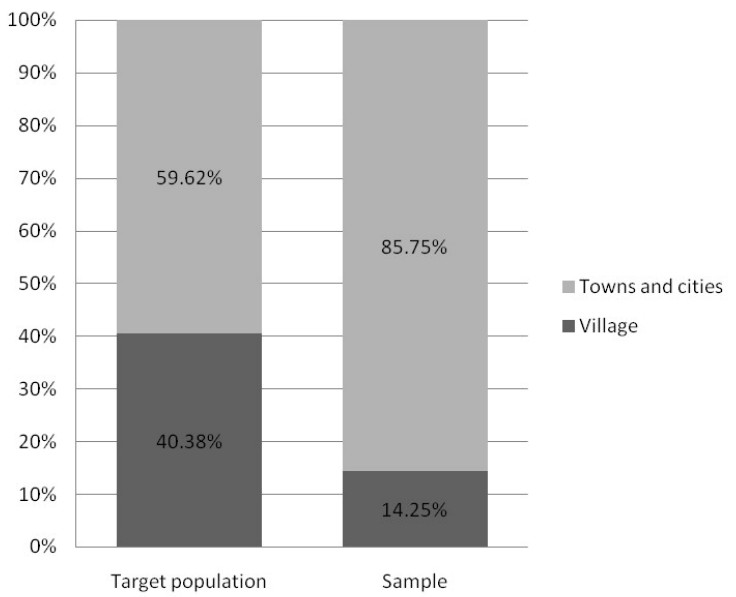
Figure 4. Chart presenting place of residence differences between study groups (based on Statistic Poland). Note: Status report on target Polish working population in the 4th quarter of 2020 according to “Yearbook of Labour Statistics 2021”; Statistics Poland.